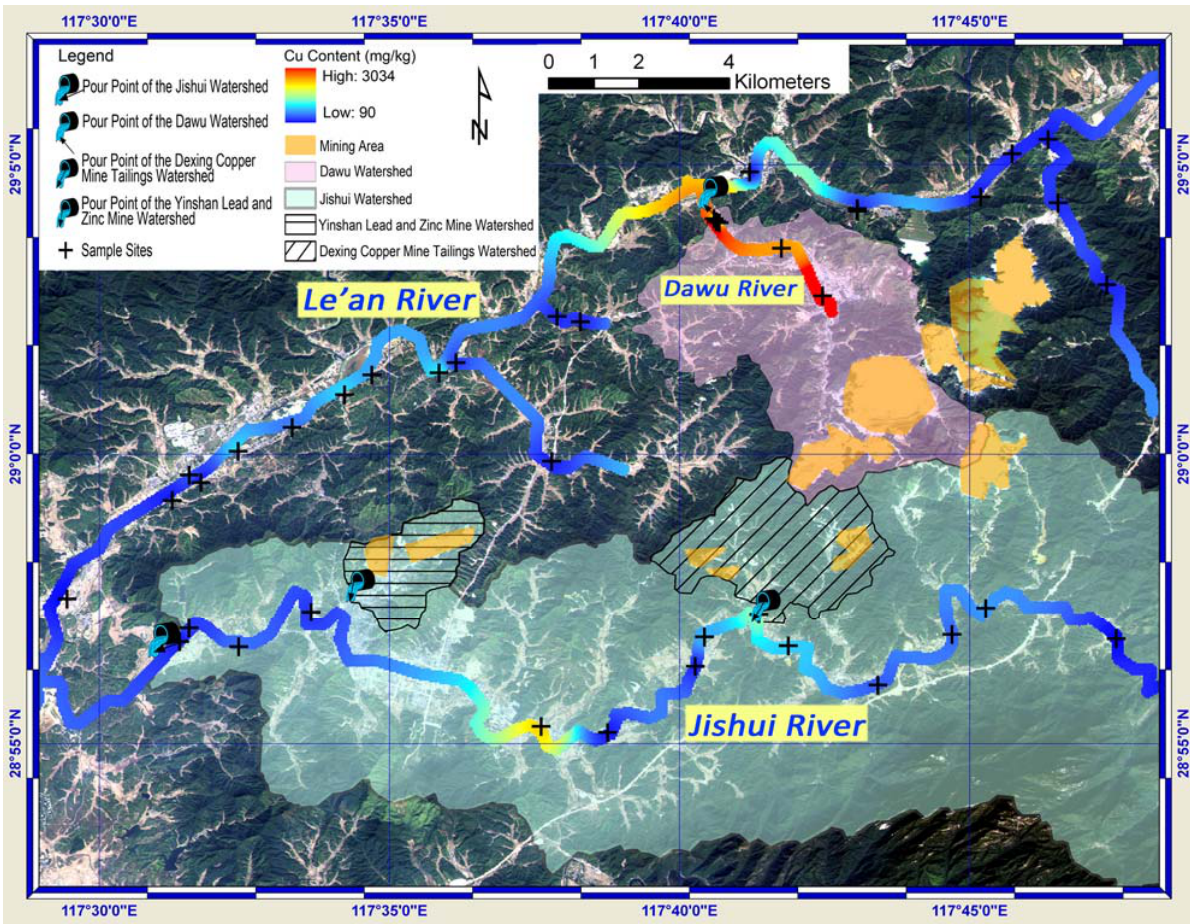
Figure 7. Spatial relationships between watersheds, mining area and total Cu